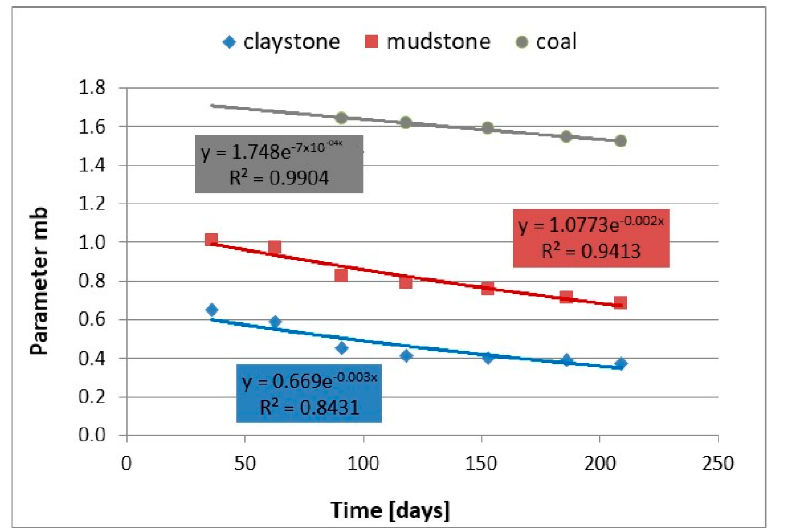
Figure 17. Changes in the post-failure parameter m b of the rocks around roadway F-33 — convergence-monitoring station at chainage 405 m.